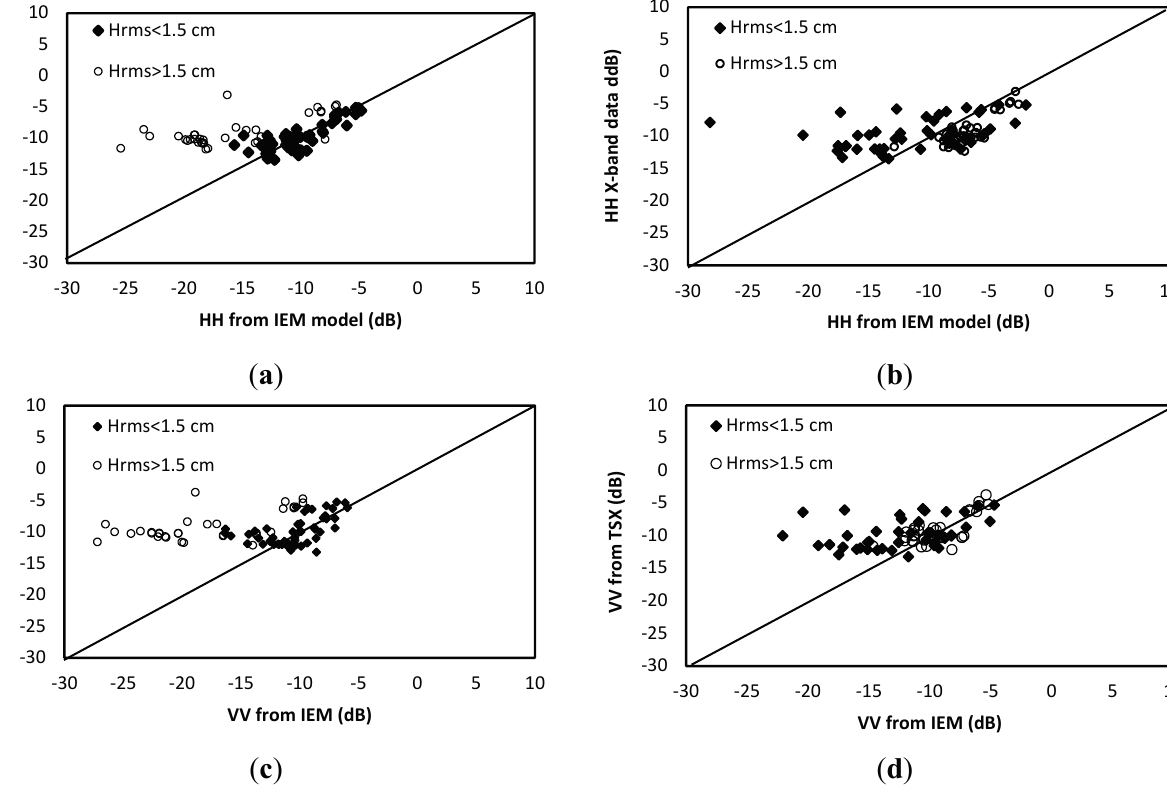
Figure 8. Comparison between measured X-band data and IEM simulations, at 36° incidence: HH polarization: ( a ) exponential correlation function and ( b ) Gaussian correlation function; VV polarization: ( c ) exponential correlation function and ( d ) Gaussian correlation